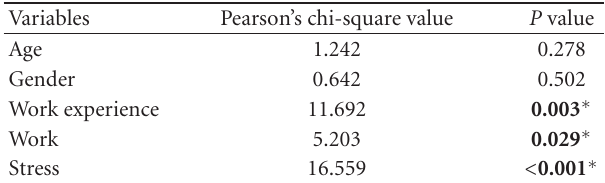
Table 1: Distribution of participants according to age, sex, work experience, work, stress, and bruxism ( N = 147).